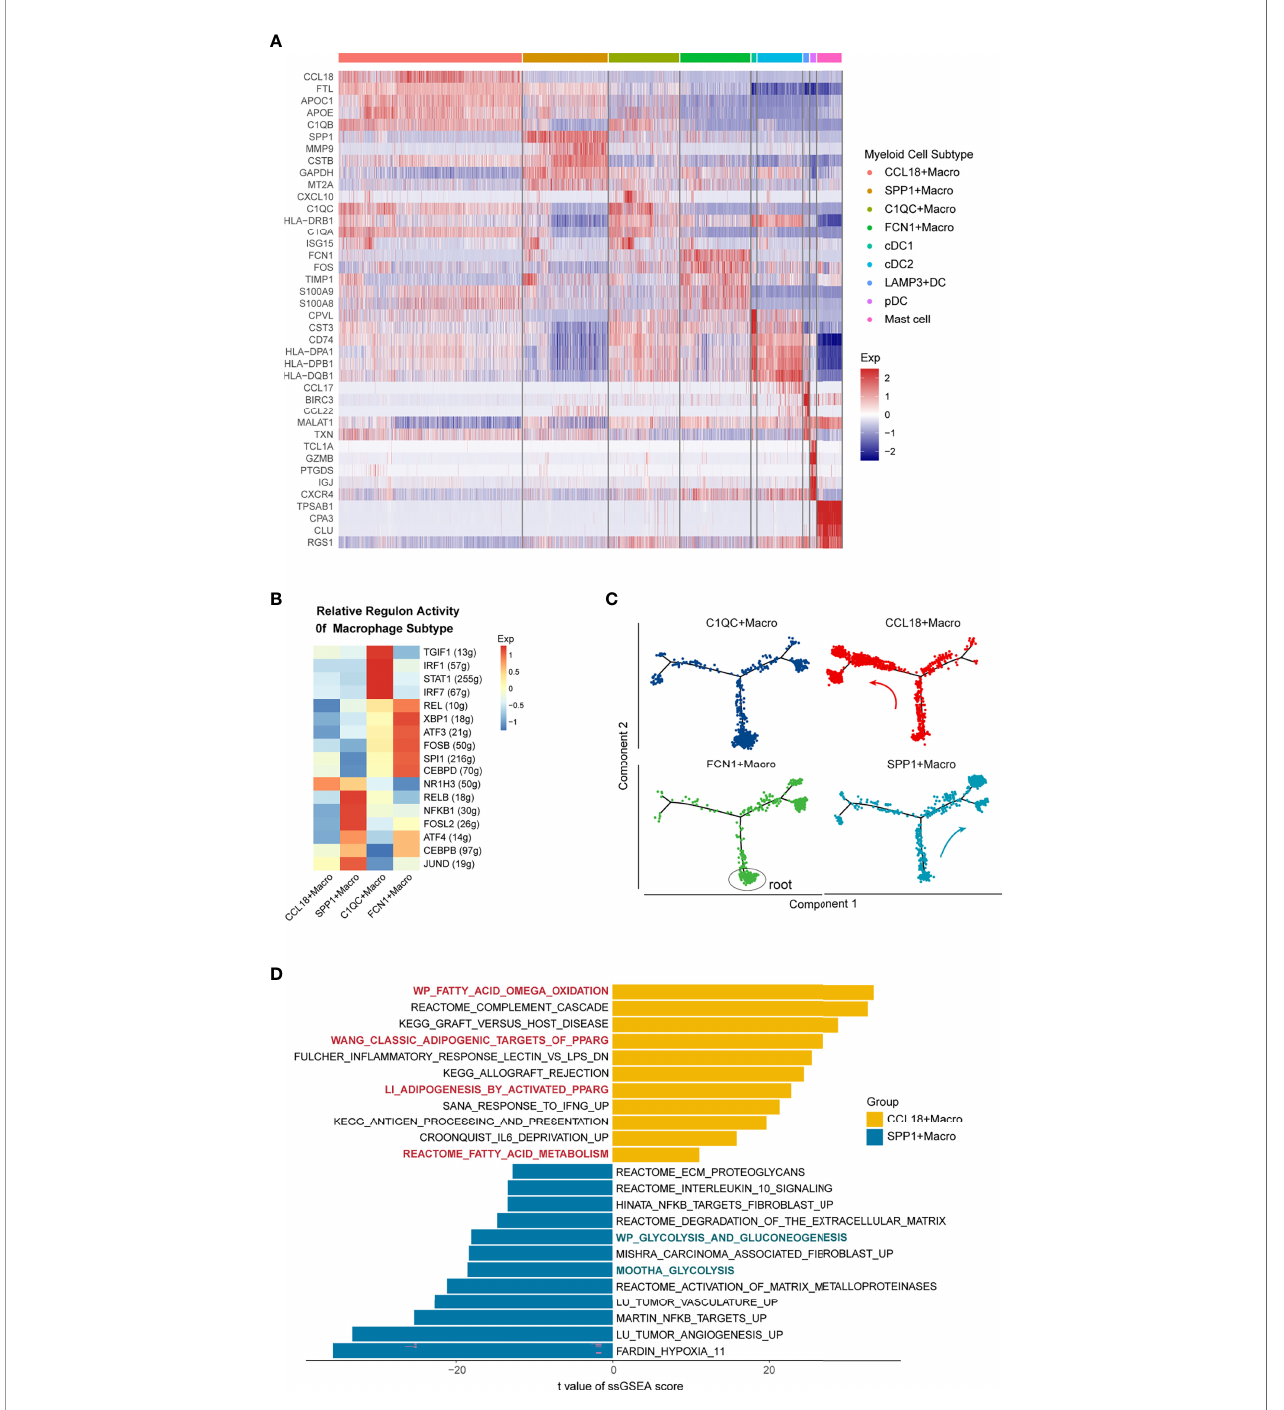
FIGURE 3 | Heterogeneity of Tumor-associated Macrophages in the Microenvironment of NSCLC. (A) Heatmap shows the top 5 differentially expressed genes of the nine myeloid clusters. (B) Heatmap showing the relative regulon activity for different TAM clusters. (C) Pseudotime trajectory of TAMs subtypes with high variable genes, colored by cell types, root cells of the trajectory were marked by the black circle. Each point represents a single cell, analyzed by Monocle2. (D) Differentially expressed pathways between CCL18+ and SPP1+ macrophage in the discovery data. Pathway activity scores were calculated by ssGSEA and compared using the limma package. T values fi tted the linear models, and p -values were adjusted by the Benjamini-Hochberg method. In CCL18+Macrophage, red indicates fatty acid metabolism pathways; In SPP1+Macrophage, green indicates the glycolysis associated